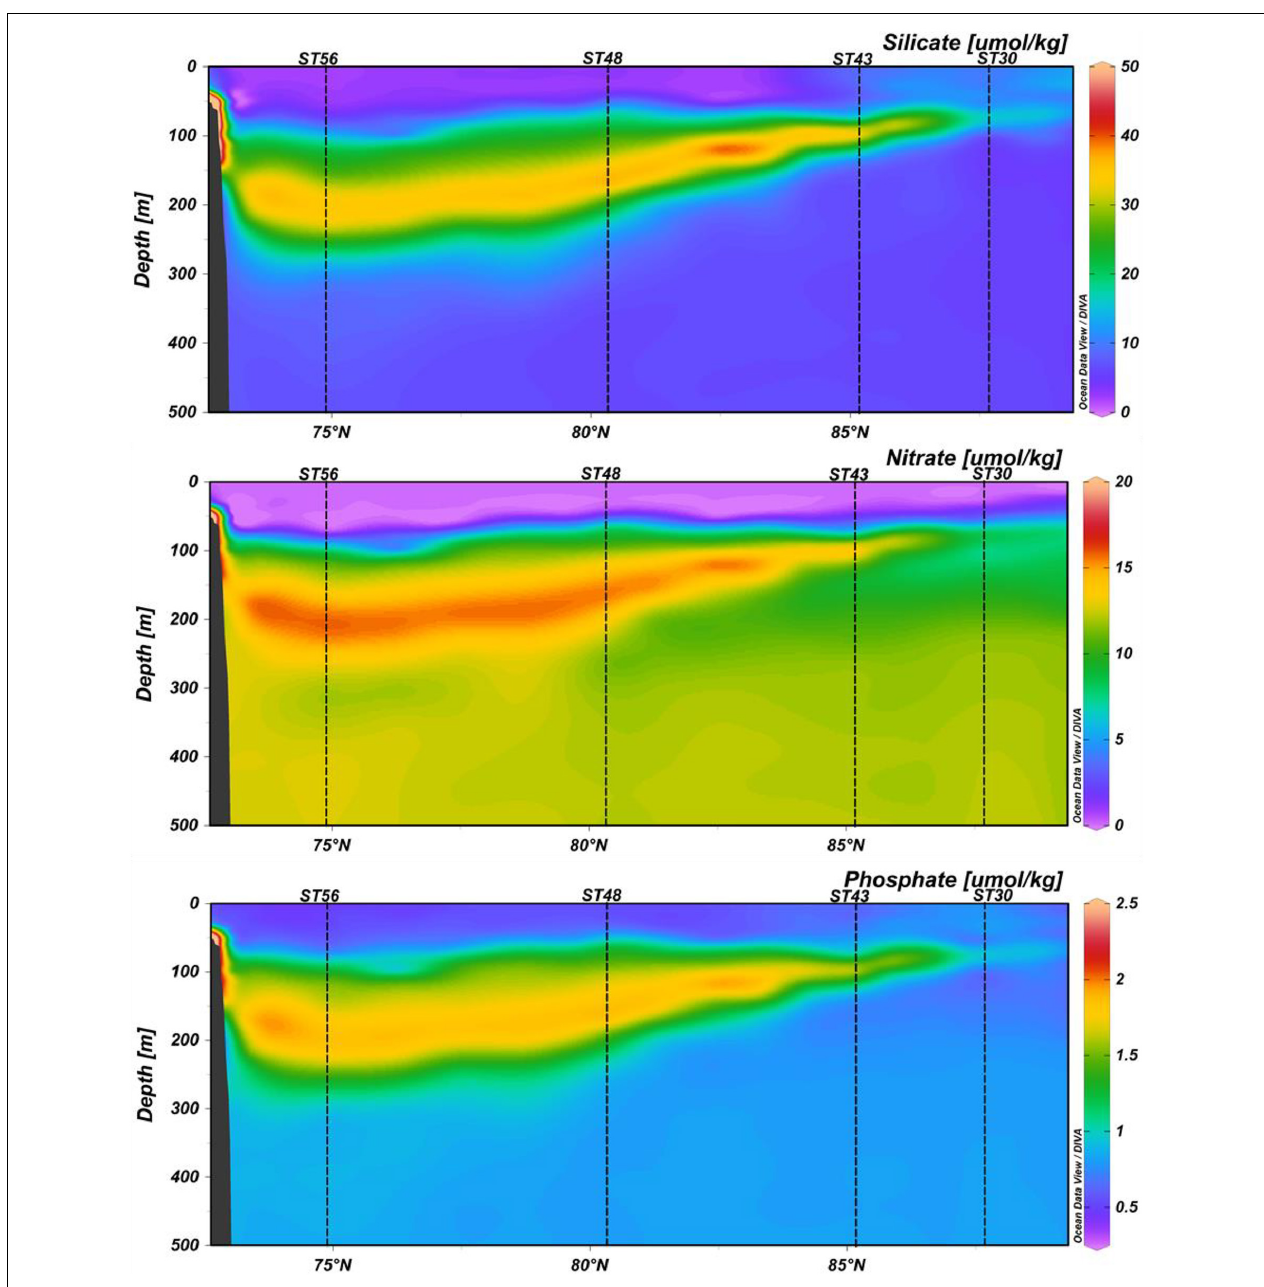
FIGURE 3 | Distribution of silicate ( µ mol/kg) nitrate ( µ mol/kg) and phosphate ( µ mol/kg) in the upper 500 m water column of the sampling transect. The transect images were created using Ocean Data View 5.2.0.